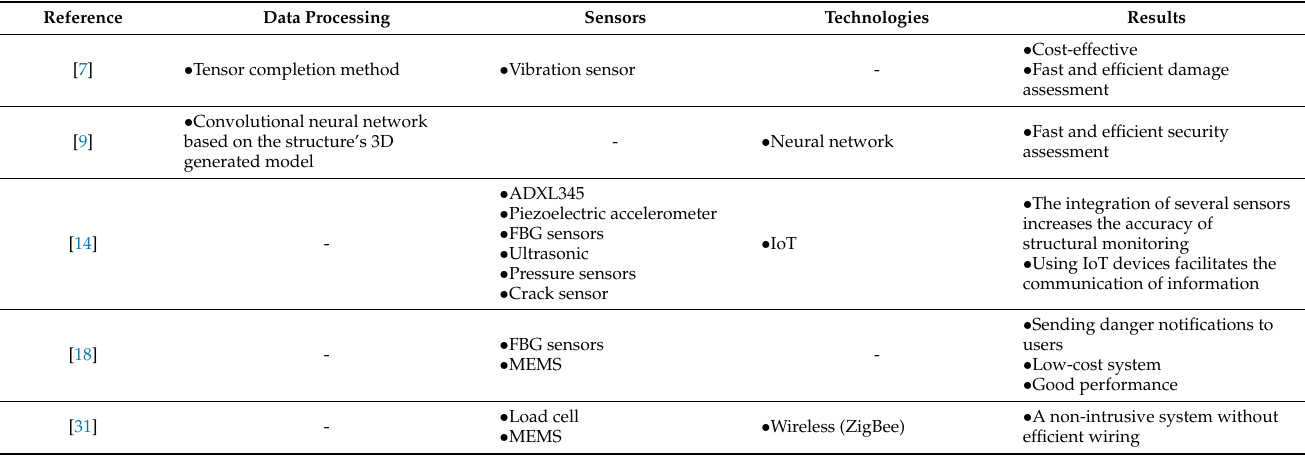
Table 2. Summary of the main characteristics and results of the state-of-the-art SHM